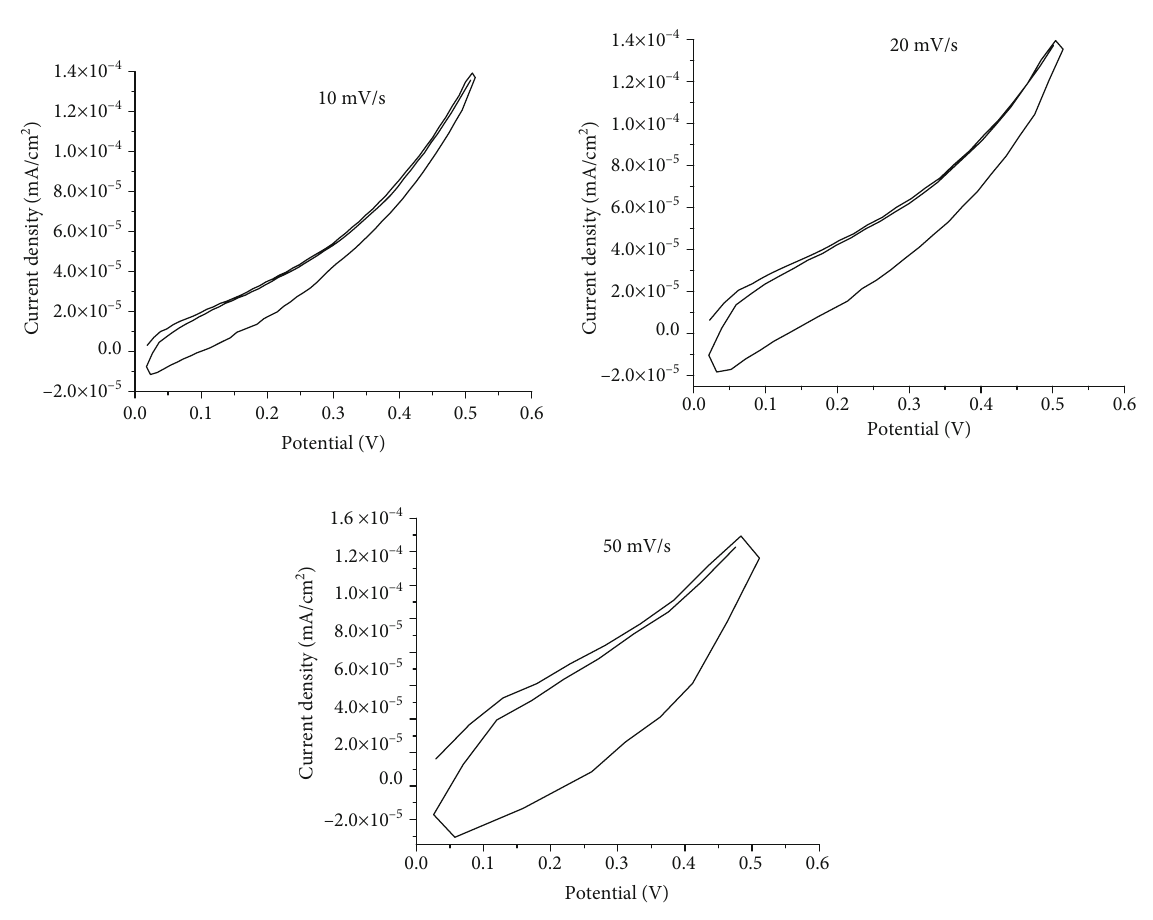
Figure 11: CV curves for the CNC device at di ff erent scan